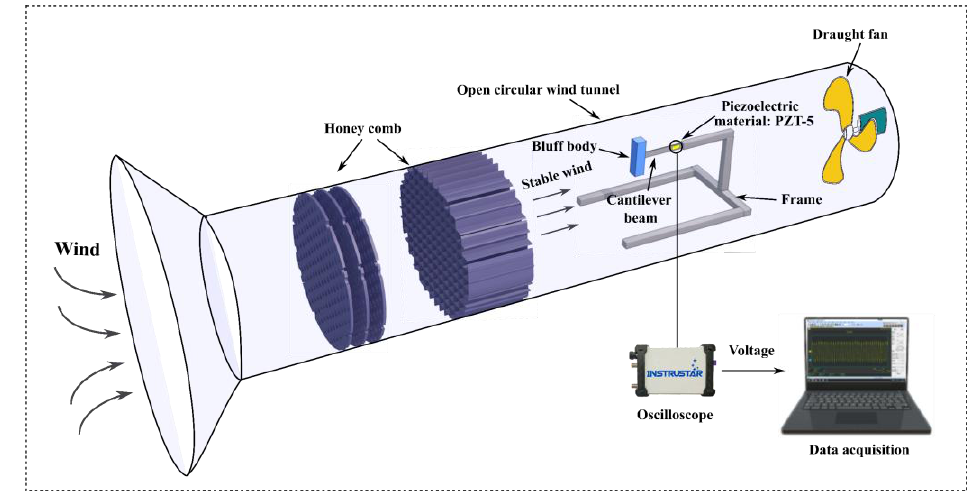
Figure 1. The wind tunnel experiment setup for stable wind, [6].